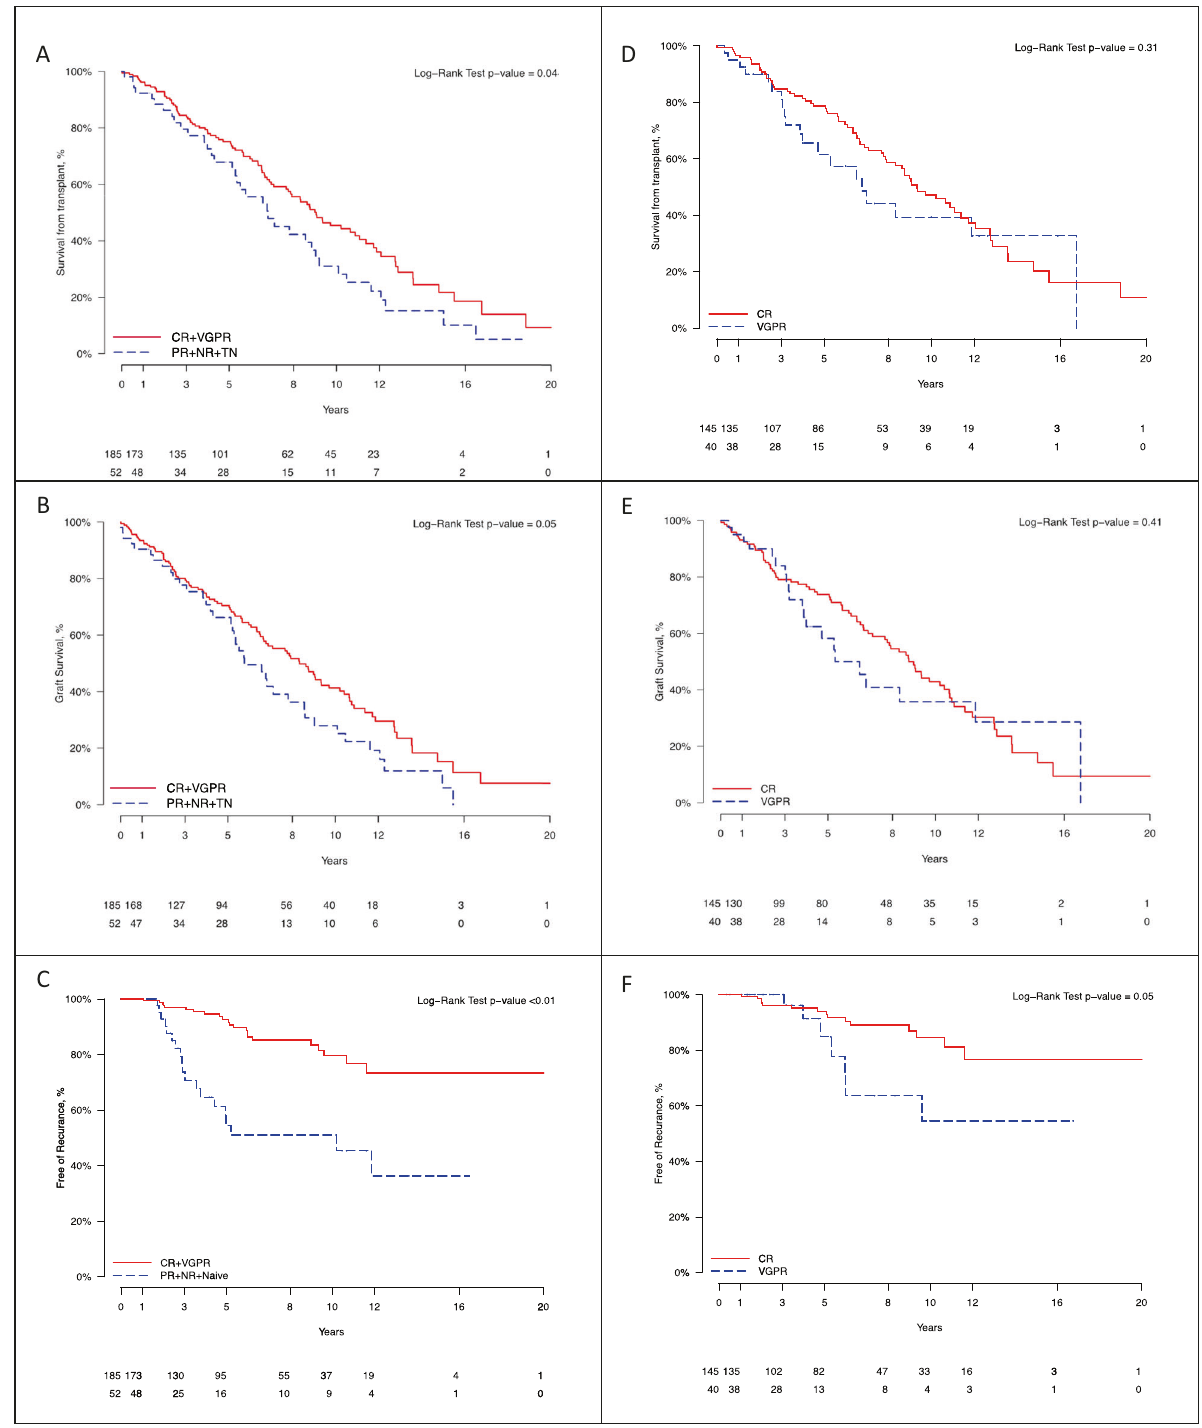
Fig. 2 Overall survival, graft survival, and amyloid recurrence according to hematologic response status at the time of renal transplantation. A Overall survival from renal transplantation: CR + VGPR vs. PR + NR + TN. B Graft survival: CR + VGPR vs. PR + NR + TN. C Time from renal transplantation to recurrence of amyloid in the graft: CR + VGPR vs. PR + NR + TN. D Overall survival from renal transplantation: CR vs. VGPR. E Graft survival: CR vs VGPR. F Time from renal transplantation to recurrence of amyloid in the graft: CR vs. VGPR. (CR - complete response, VGPR very good partial response, PR partial response, NR no response, TN treatment [30]. Another factor that led to heterogeneity in identifying were Caucasian. This bias is mainly due to the demographics of amyloid recurrence in the graft includes protocol versus clinically the countries participating in the study but, under-diagnosis of AL indicated biopsies. Protocol biopsies might have led to earlier amyloidosis in other ethnicities and the racial and ethnic detection and treatment of amyloid recurrence in the graft when disparities in access to renal transplant likely also contributed